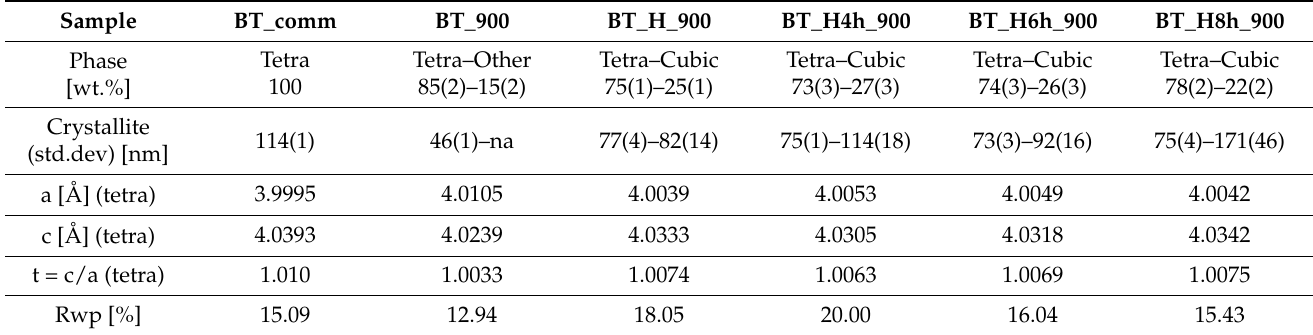
Table 3. Quantitative phase analysis, crystallite size, and lattice parameters of undoped BT